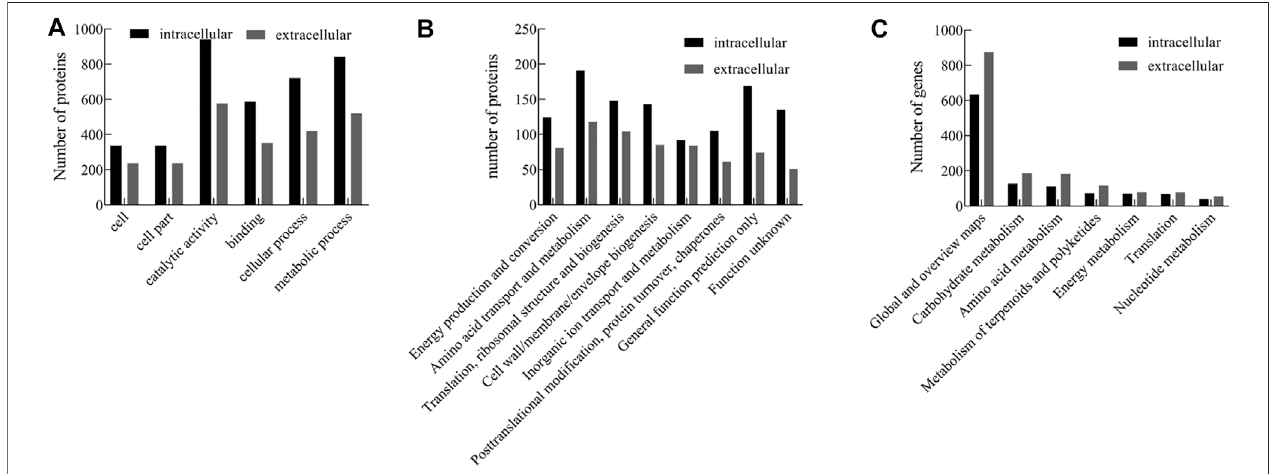
FIGURE 3 | GO (A) , COG (B) , and KEGG (C) pathway analysis of intracellular and extracellular proteins from Microbulbifer sp. ALW1.